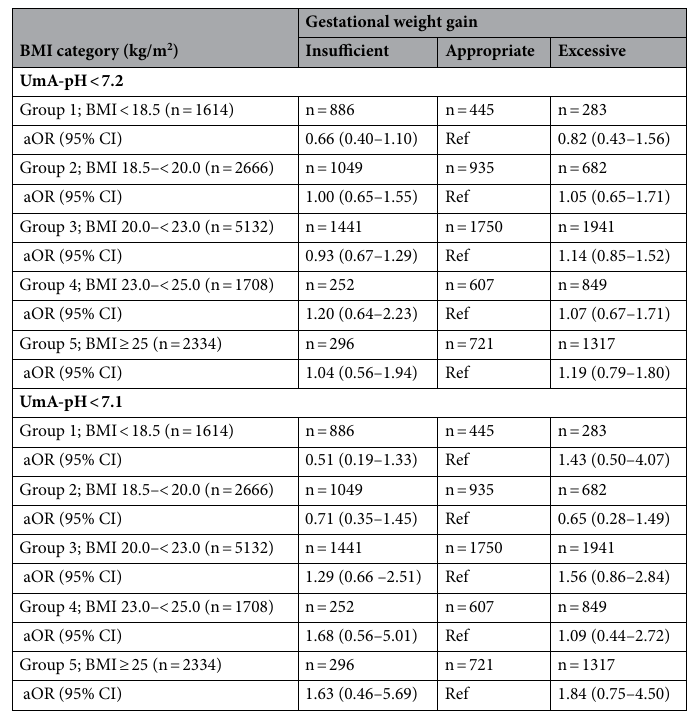
Table 5. Adjusted odds ratios a and 95% confidence intervals for foetal acidosis based on gestational weight gain with caesarean section according to Japanese criteria 28 . Logistic regression models were used to calculate the adjusted odds ratios and 95% confidence intervals for UmA-pH < 7.20 and for UmA-pH < 7.10, with women with appropriate gestational weight gain as the reference. BMI body mass index, UmA-pH umbilical artery pH. a Adjusted for maternal age, maternal education, annual household income, maternal smoking during pregnancy, parity, preterm birth and small-for-gestational age